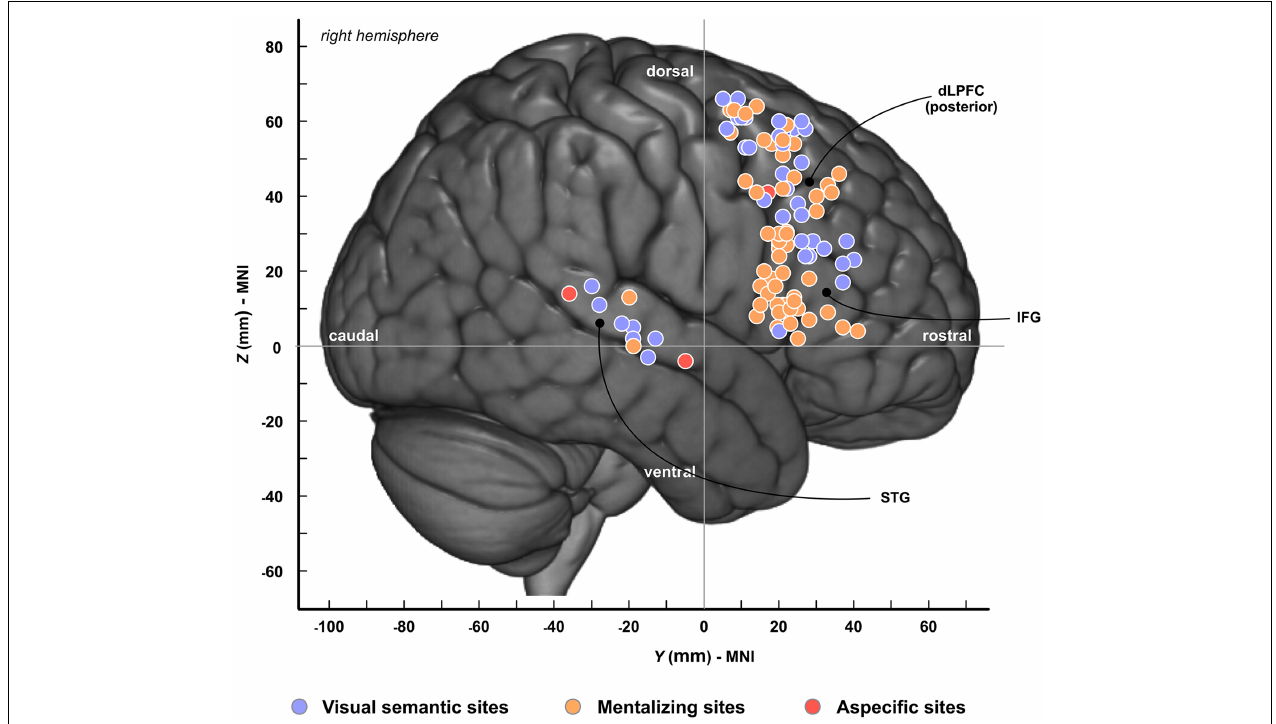
FIGURE 2 | Spatial topography of cortical sites. Cortical sites are plotted onto the MNI-152 template. Colors refer to the type of neuropsychological impairments induced by electrostimulation. Blue, visual semantic cognition; Orange, mentalizing; Red, sites associated with both visual semantic cognition and mentalizing. dlPFC, dorsolateral prefrontal cortex; IFG, inferior frontal gyrus; STG, superior temporal gyrus.